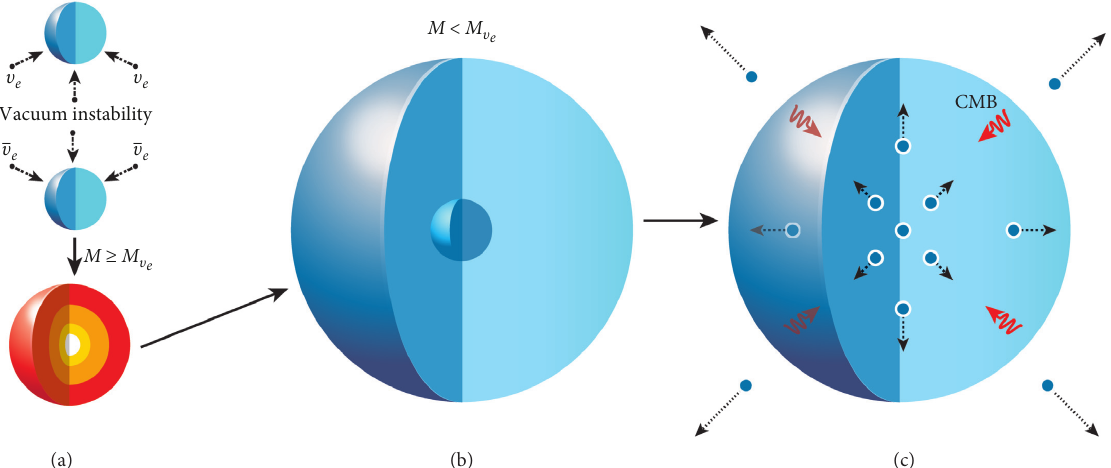
Figure 2: Summary schematic of the ATLAS model. (a) Assuming that antimatter has negative gravitational mass, the quantum vacuum is unstable and forms spatially separated neutrino stars and antineutrino stars. An antineutrino star collapses in a neutrinonova when its mass exceeds the Chandrasekhar limit. A large fraction of the kinetic energy released in the collapse converts to baryons and antibaryons. After baryogenesis and nucleosynthesis, the surviving baryons and antineutrinos expand adiabatically. (b) Structure formation begins in a much smaller volume for baryons (inner sphere) than for antineutrinos (outer sphere). (c) The antineutrino star remnant returns to hydrostatic equilibrium, emits isothermal cosmic microwave background radiation and radially accelerates matter. If we are close to the core, this model could explain the overall expansion of